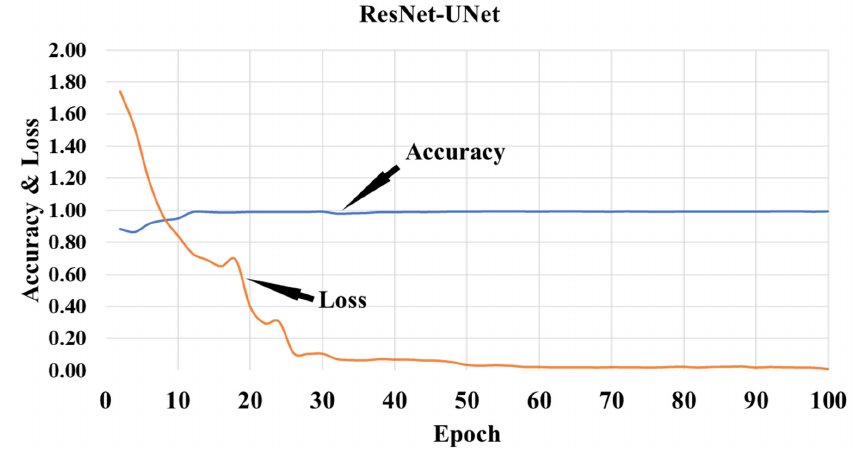
Diagnostics 2022 , 12 , 1283 Figure 10. Training accuracy and loss plot for the best AI model (ResNet ‐ UNet). Figure 10. Training accuracy and loss plot for the best AI model (ResNet-UNet).